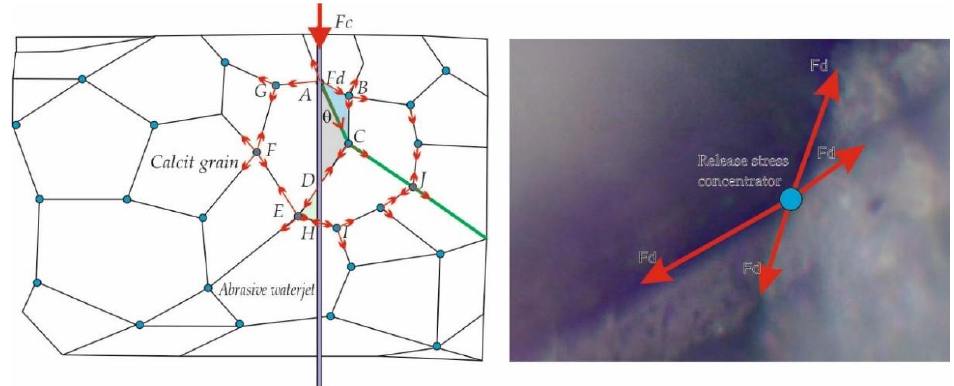
Figure 1. The model of propagation of the separation forces of the grains in marble, under the action of an external cutting force.